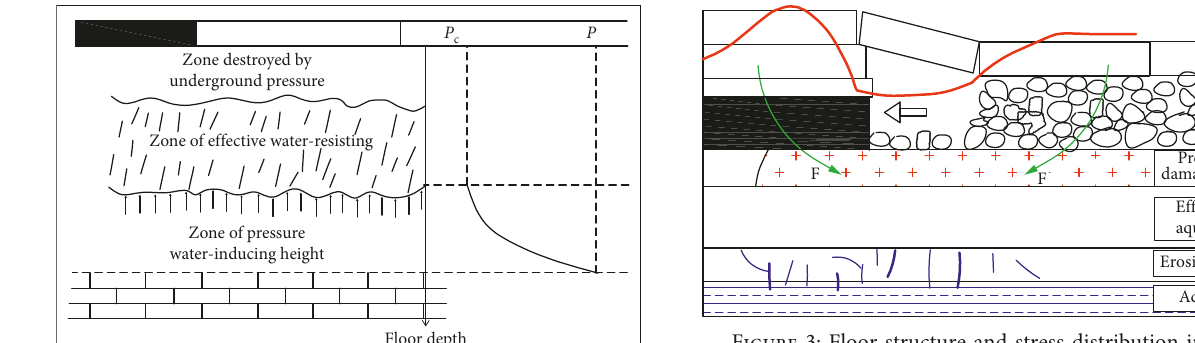
Figure 3: Floor structure and stress distribution in goaf.